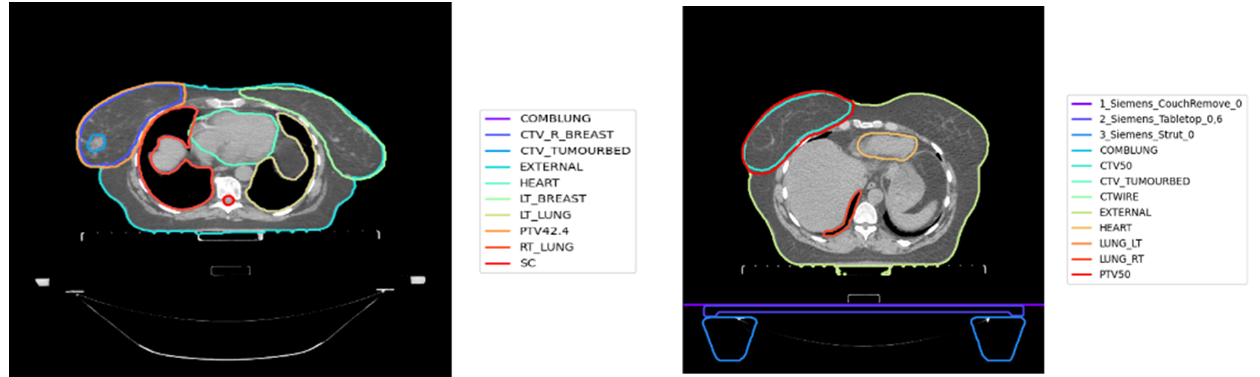
Figure 1. Variations in OARs and TVs for two breast cancer patients. ( Left image ): breast ctv named CTV_R_BREAST; left lung named LT_LUNG; right lung named RT_Lung. ( Right image ): breast ctv as CTV_50; left lung as LUNG_LT; right lung as LUNG_RT.